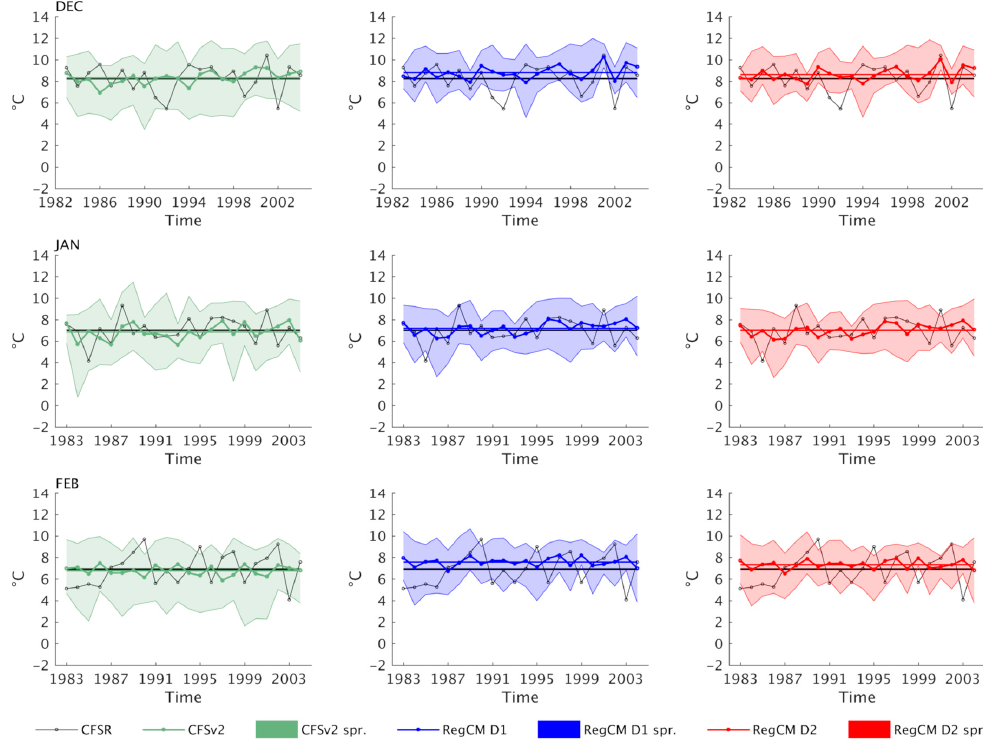
Figure 4. CFSv2 (left column), RegCM-d1 (central column), and RegCM-d2 (right column) ensemble mean inter-annual variability (dotted lines) and climatological period mean (solid lines) compared to the reanalysis (black lines). Shades represent ensemble spread (between lowest and highest monthly values) for the three seasonal forecast products.